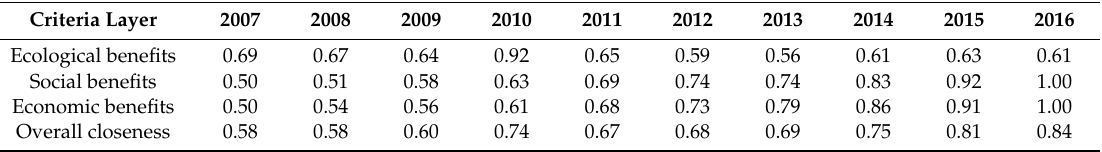
Table 4. Results of the water environment integrated governance performance evaluation in Henan Province